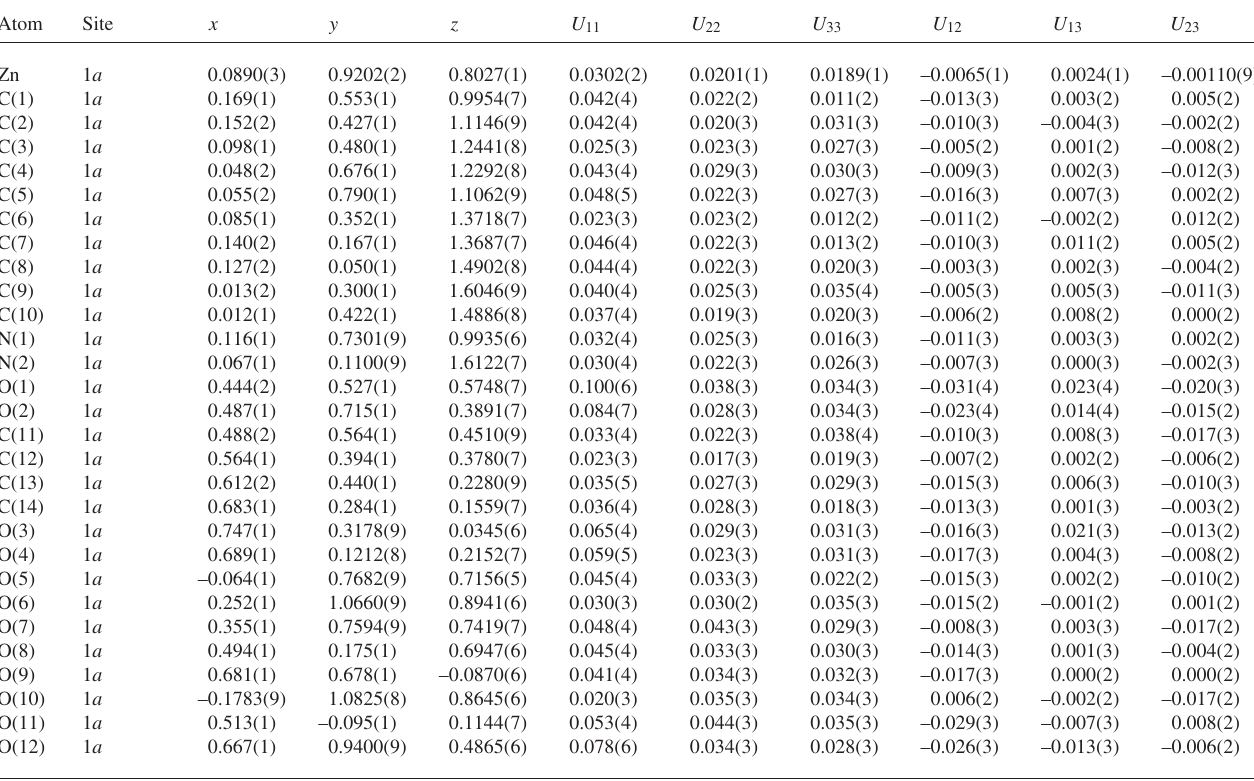
Table 3. Atomic coordinates and displacement parameters (in Å 2 )